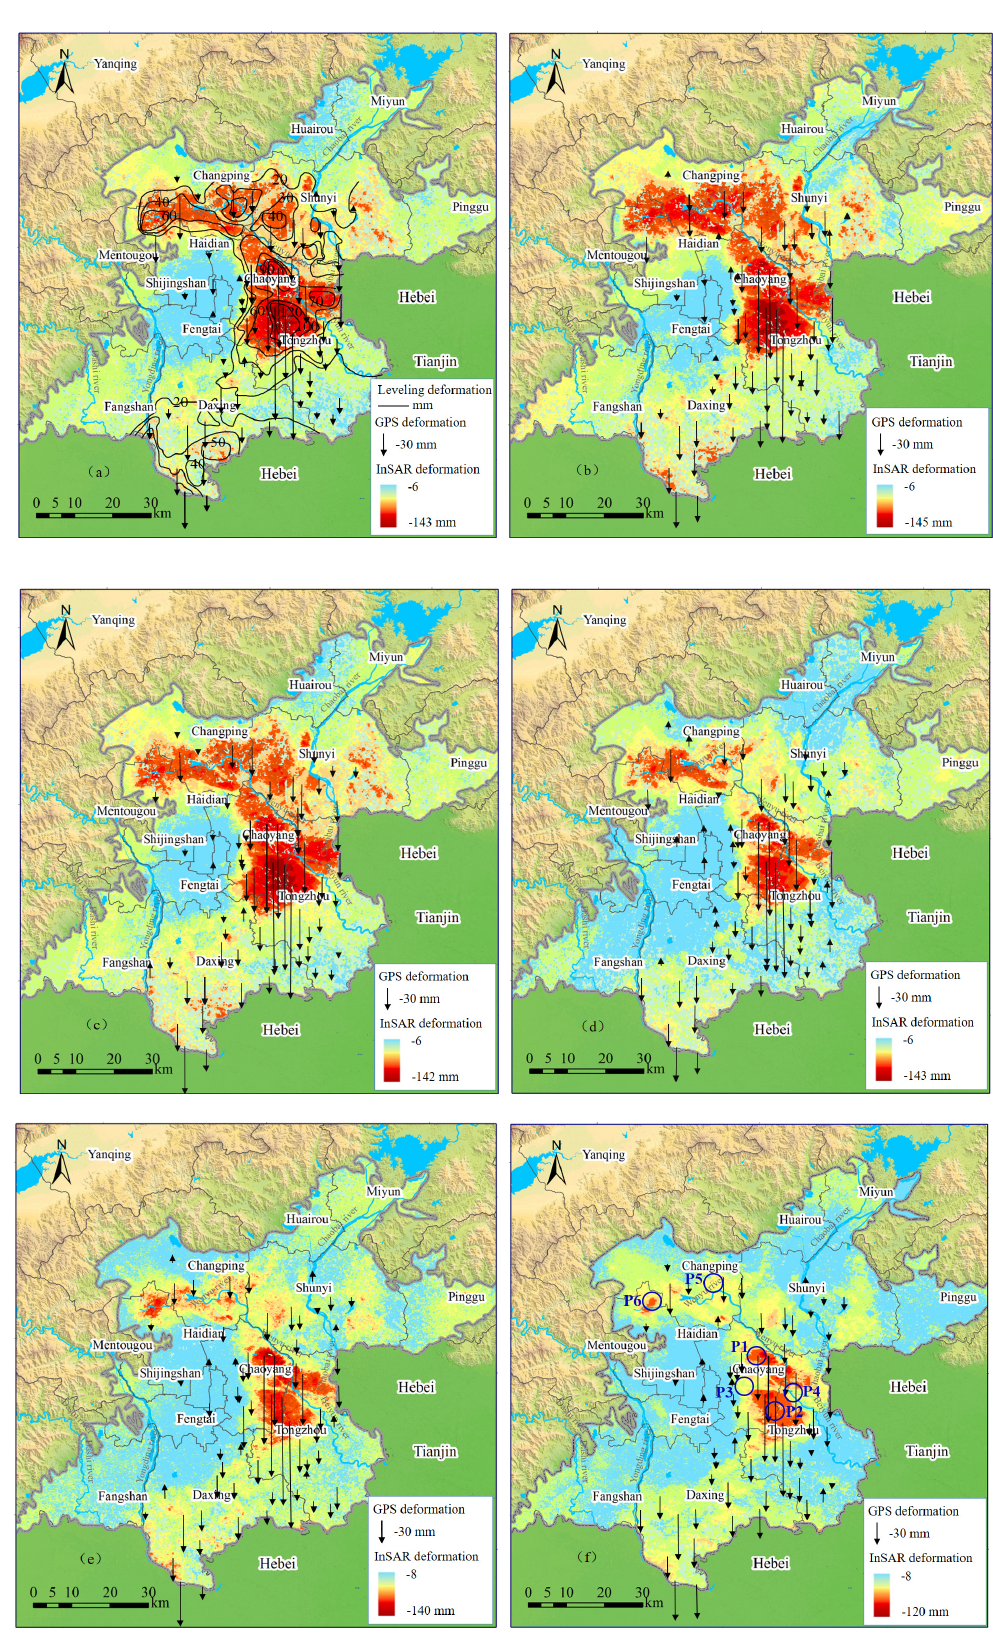
Figure 4. The distribution characteristics of land subsidence in Beijing Plain (2013~2018). ( a ) 2013. ( b ) 2014. ( c ) 2015. ( d ) 2016. ( e ) 2017. ( f ) 2018.